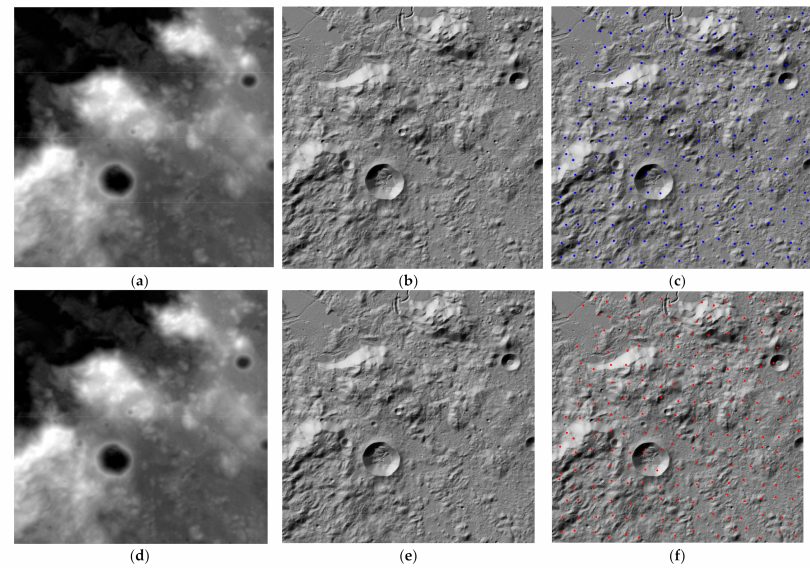
Figure 4. Examples of matching result of a 5 ◦ × 5 ◦ image block centered at (2.5 ◦ E, 22.5 ◦ N). ( a ) SLDEM2015; ( b ) simulated image (SLDEM2015); ( c ) final control points (SLDEM2015); ( d ) CE1_TMap_GDOM_120m; ( e ) simulated image (CE2TMap2015_DEM_20m); ( f ) final control points